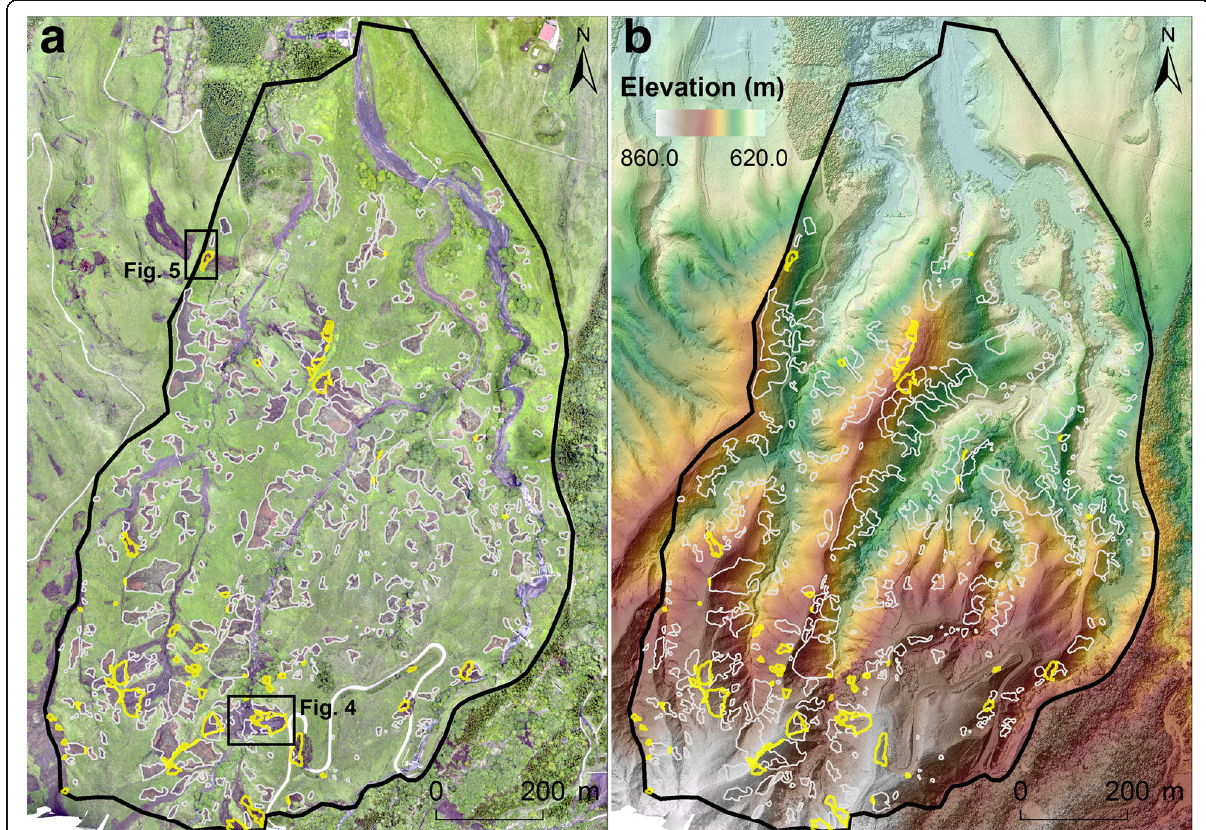
Fig. 3 Distributions of landslide initiation areas triggered by the 2016 Kumamoto earthquake (yellow polygons) and the heavy rainfalls of 2012 (white polygons) with the a orthorectified images and b digital surface models (DSMs), with a spatial resolution of 0.06 m, acquired in May 2016. The black polygon shows the study area. Details in the black rectangles are shown in Figs. 4 and 5,